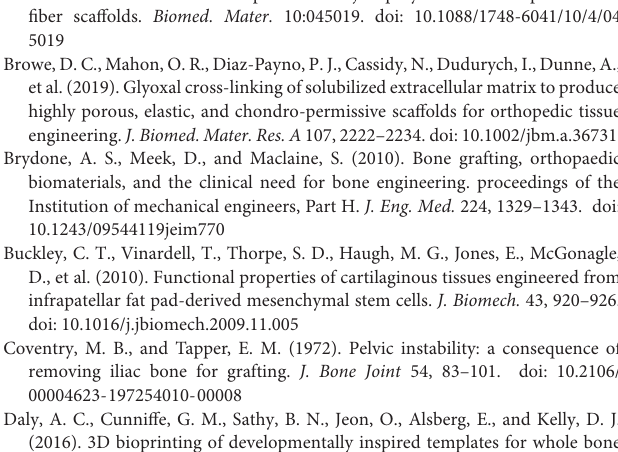
FIGURE S1 | (A) Masson’s Trichrome stained sections of control scaffolds after 8 weeks in vivo . Images taken at 20X. (B) Representative X-ray images of the three control groups 8 weeks after implantation. Quantification of the amount of panel (C) total number of vessels, (D) percentage new bone, and (E) bone union score for all three control groups 8 weeks post implantation. Error bars denote standard deviation, n = 2 animals. FIGURE S2 | Goldner’s Trichrome stained sections of control scaffolds after 8 weeks in vivo . Red arrow heads denote mature vessels perfused with erythrocytes. Images taken at